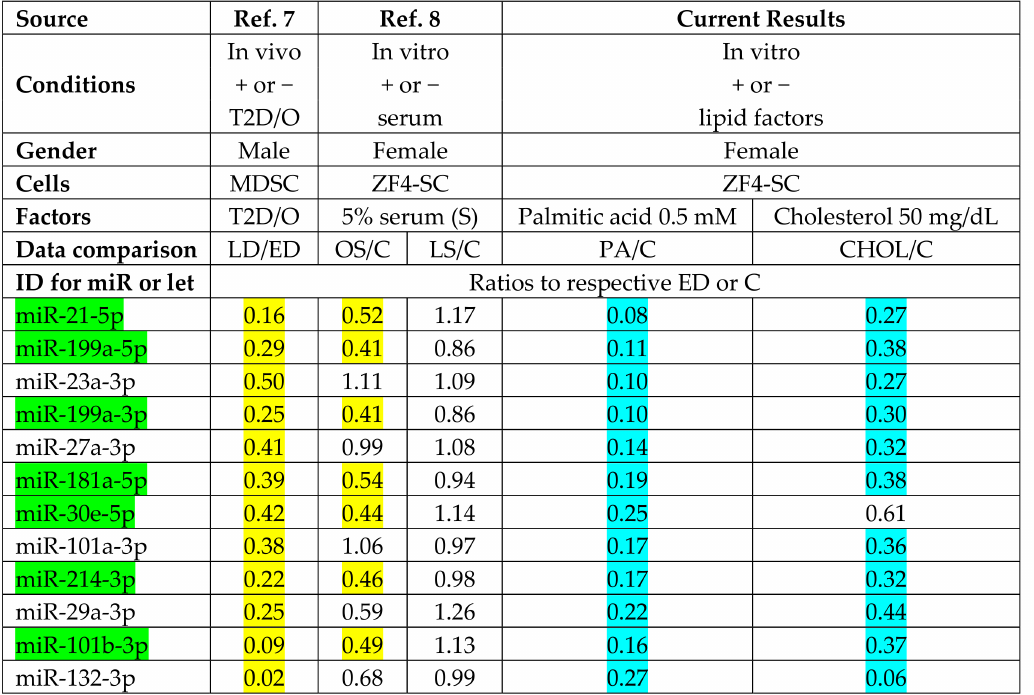
Table 1. Despite the observed mild overexpression of myostatin protein by cholesterol and its lack of induction by Na palmitate in ZF4-SC, the miRs related to myostatin, were also inhibited by the lipid factors. The current results are shown on the right two columns, for RNA isolated from the standard 4 days incubations of ZF4-SC with Na palmitate and cholesterol or no addition, which were assayed for their miR-global transcriptional signatures (miR-GTS). Only individual miRs related to myostatin expression were selected for tabulation, previously arranged by their level of expression on male MDSC exposed in vivo to type 2 diabetes / obesity (T2D / O) [7] on LD-MDSC vs. non T2D / O in ED- MDSC. Blue highlighting for current results shows downregulation < 0.50 against controls. Yellow highlighting is similarly applied to the same miRs previously reported both in male rats in vivo [7] and in vitro with dyslipidemic Obese Zucker (OZ) serum in female rats [8], and now are included as a reference. Green highlighting is for the miRs, which previously were shown to be in agreement with the in vitro results with dyslipidemic serum in female